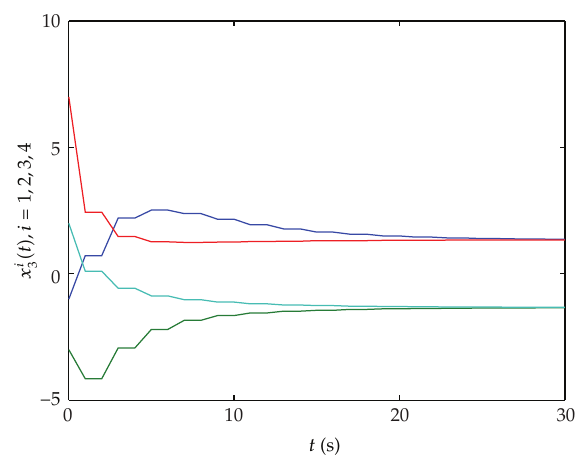
(cid:6) t (cid:7) , i (cid:9) 1 , 2 , 3 , 4 for G 3